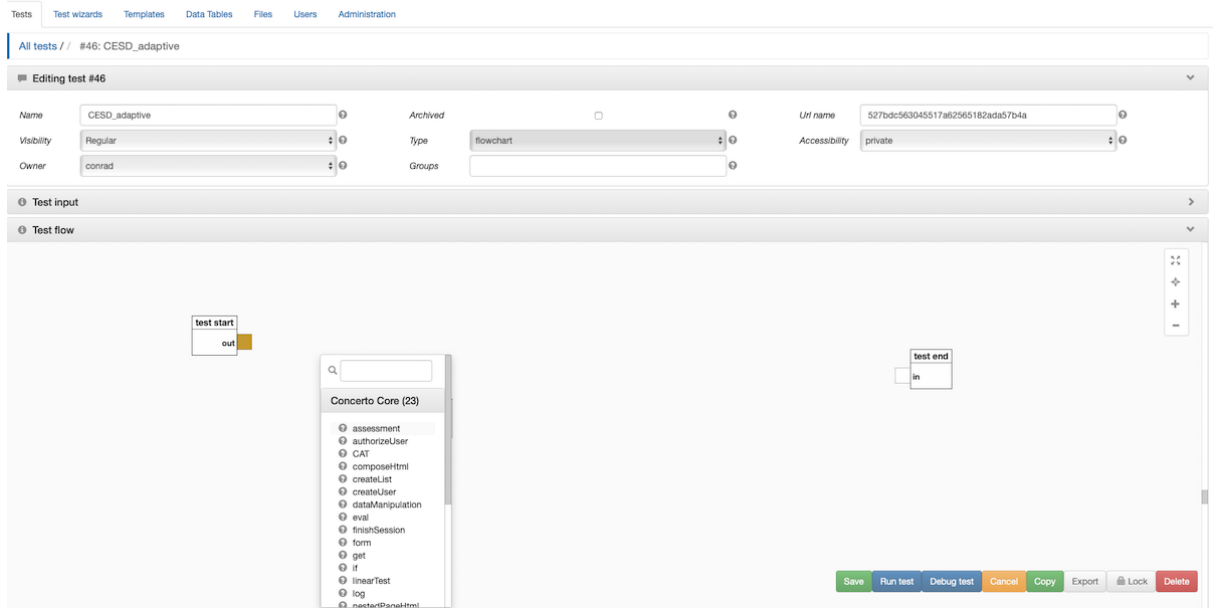
Figure 2. Concerto screenshot: opening the